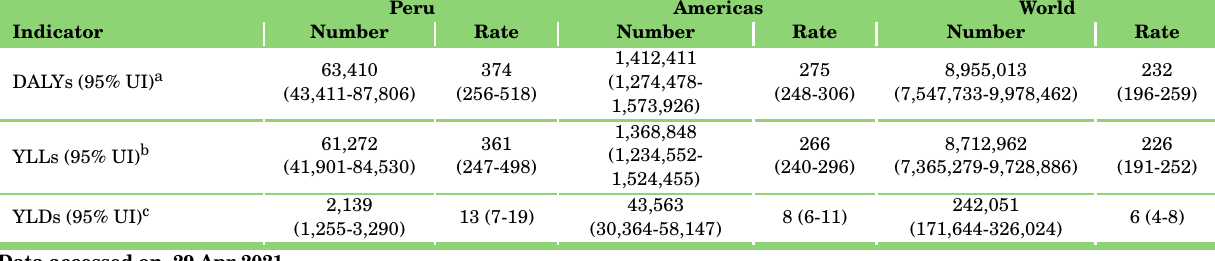
GBD2019DiseasesandInjuriesCollaborators. Globalburdenof369diseasesandinjuriesin204countriesandterritories,1990-2019: asystematicanalysisfortheGlobalBurdenofDisease Study 2019. Lancet. 2020 Oct 17;396(10258):1204-1222